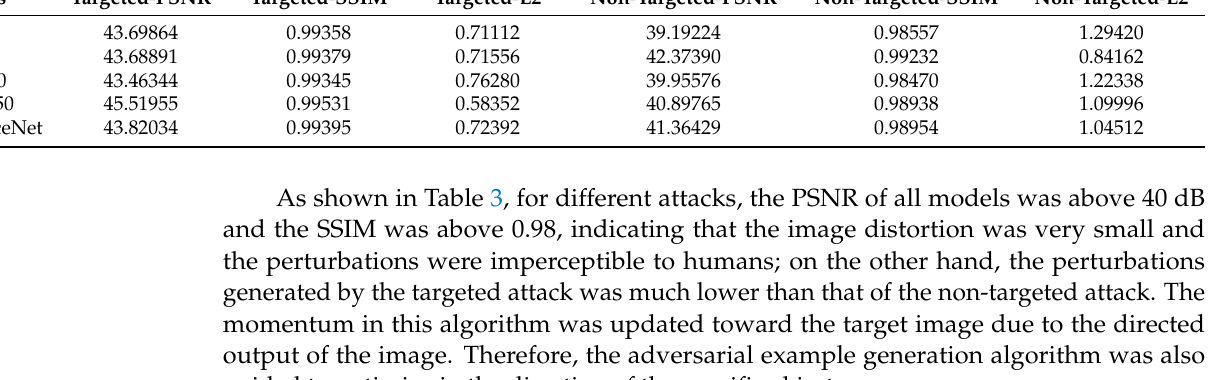
Table 2. The accuracy and success rates of different models under the specified thresholds.